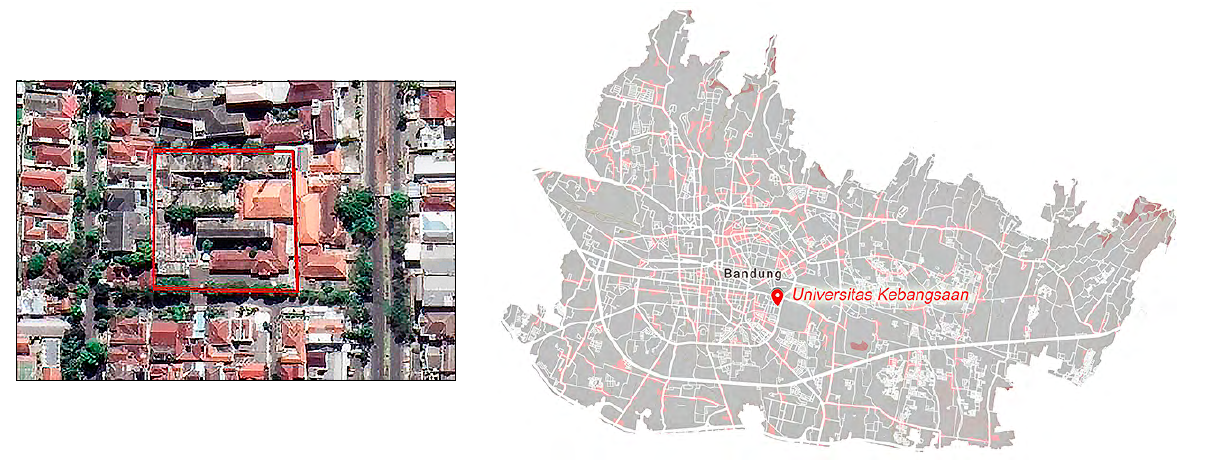
Figure 3. Location of case study in urban context of Bandung